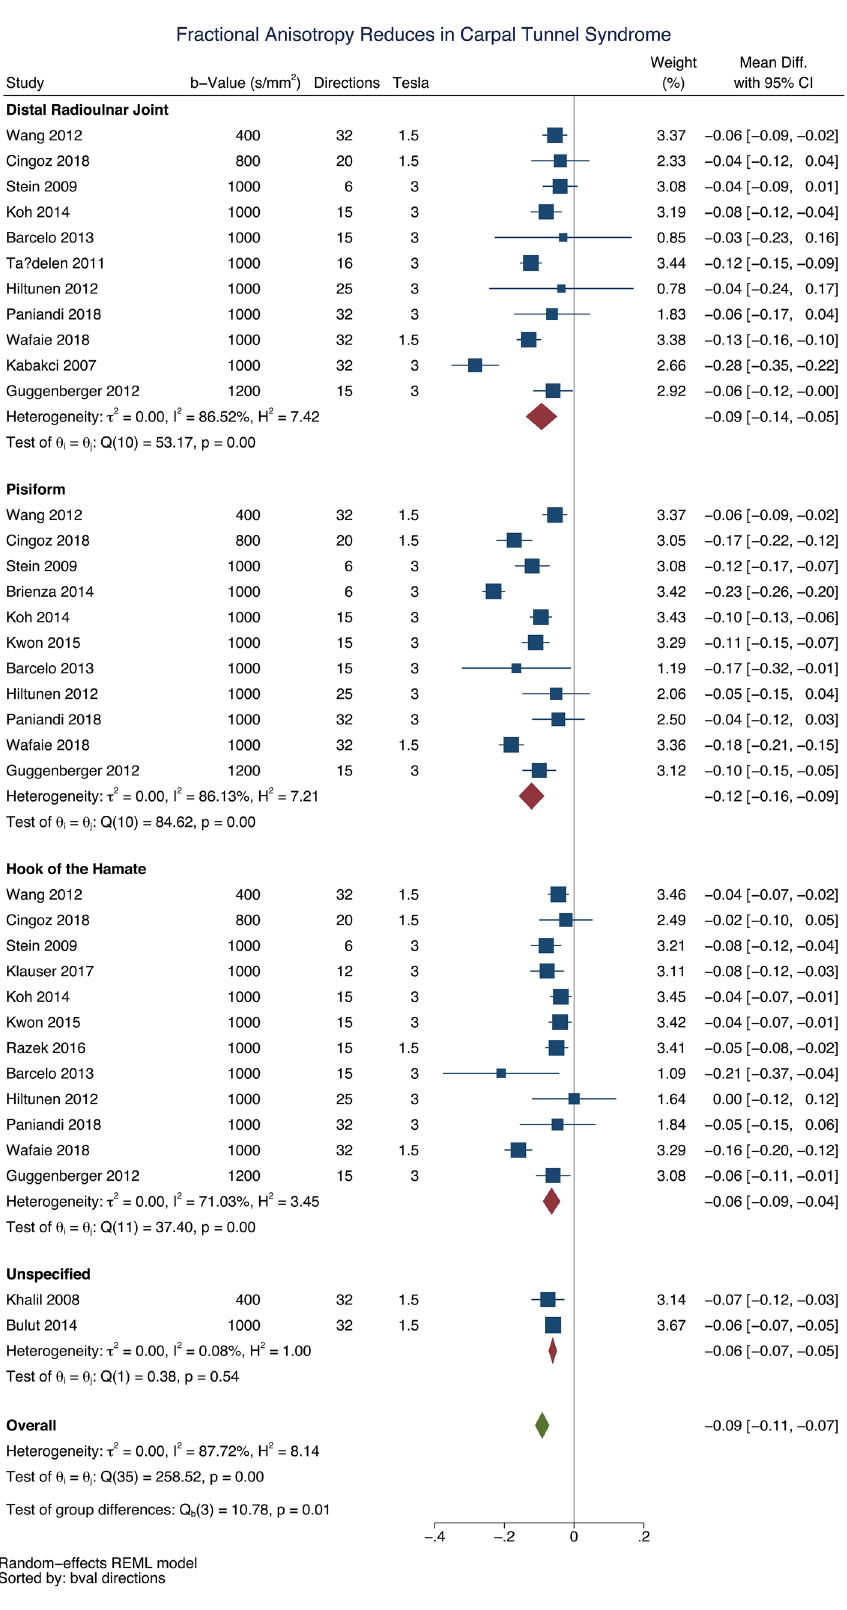
Figure 2. A forest plot of the fractional anisotropy of the median nerve, at 3 anatomical levels, between asymptomatic adults and patients with carpal tunnel